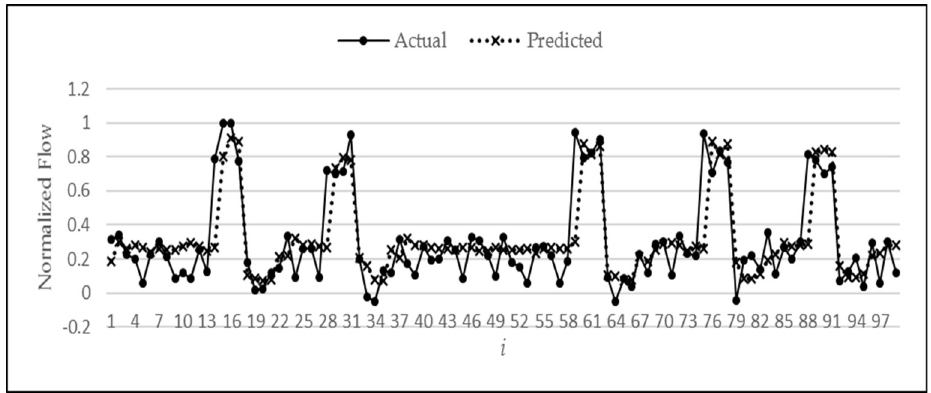
Figure 9. Plot of actual vs. predicted values of synthetic test